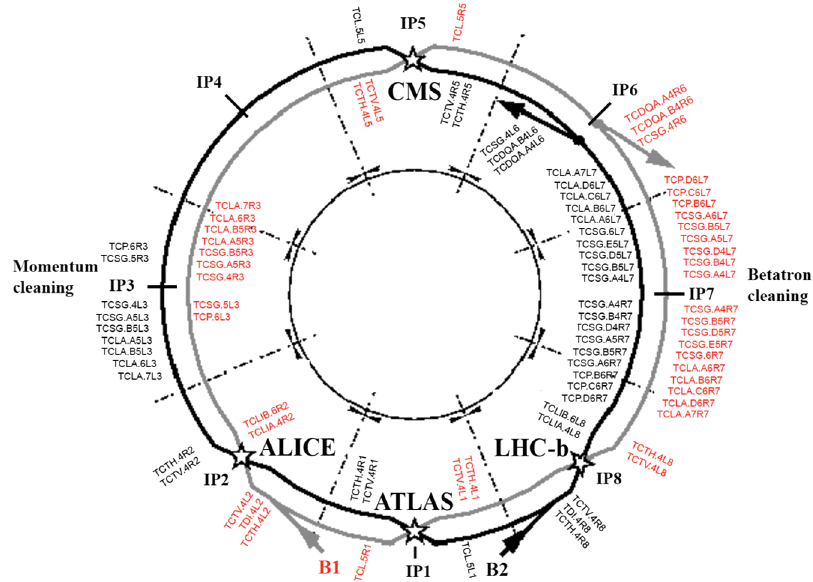
FIG. 1. LHC collimator layout from [27]. Collimators are located mainly in IR3 and IR7 (on the left and right of the illustration), but also protect the experiments, the beam dump, and the transfer line regions.